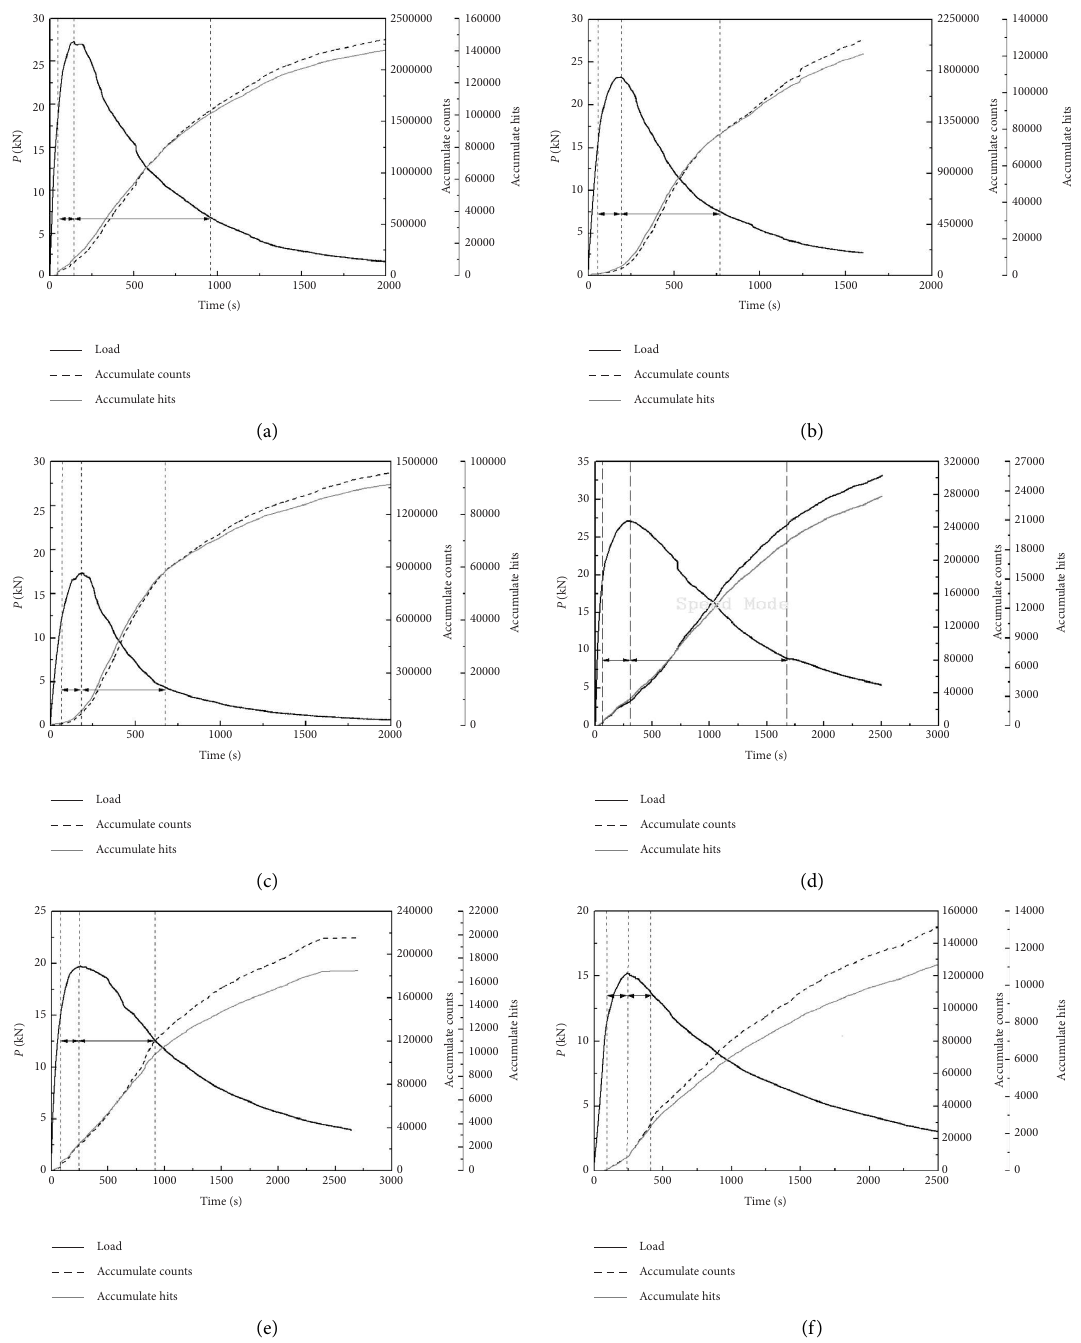
Figure 6: Te cumulative AE counts and event time history curves. (a) WS300-0.3, (b) WS300-0.4, (c) WS300-0.5, (d) WS450-0.3, (e) WS450-0.4, and (f)